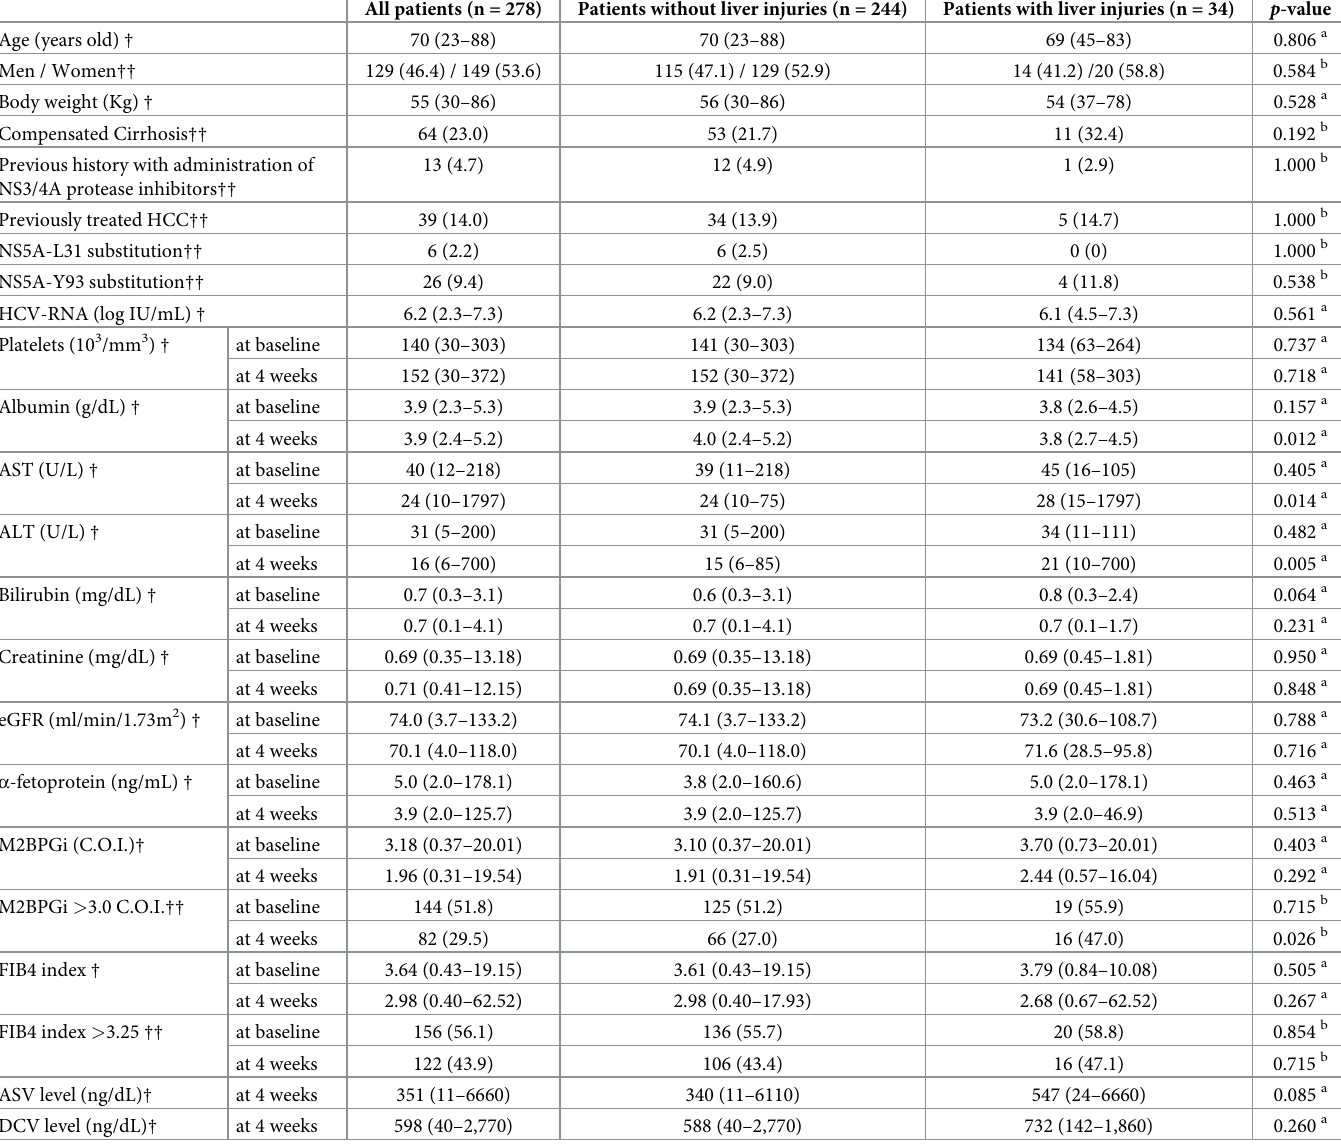
Table 1. The demographic and clinical features of 278 patients with genotype 1b hepatitis C virus (HCV) infection receiving daclatasvir (DCV) plus asunaprevir (ASV) therapy. All patients (n = 278) Patients without liver injuries (n = 244) Patients with liver injuries (n = 34) p